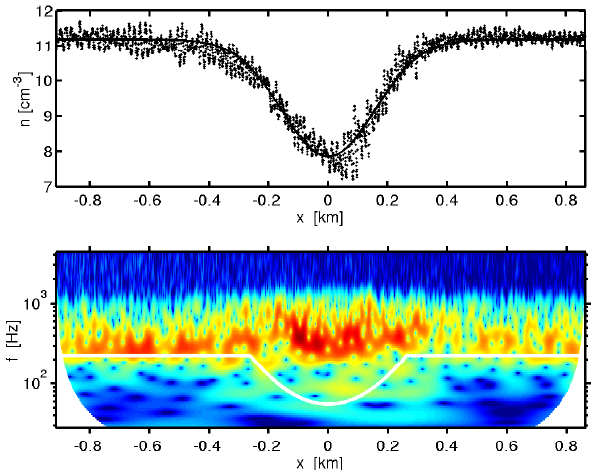
Fig. 5. An example on how to apply the theory to measured data, in this case the Cluster event analyzed by Tjulin et al. (2003). The dots in the upper panel is the density, derived from the spacecraft potential from the EFW instrument, and the white line is the fitted Gaussian ( b = 220m). The lower panel is a wavelet spectrogram of the duskward electric field. The solid line is a fit to the lowest fre- quency in the spectrogram. We have k z = 2 . 5 × 10 − 4 m − 1 , 1 = 0 . 33 and r 0 = 73m for this